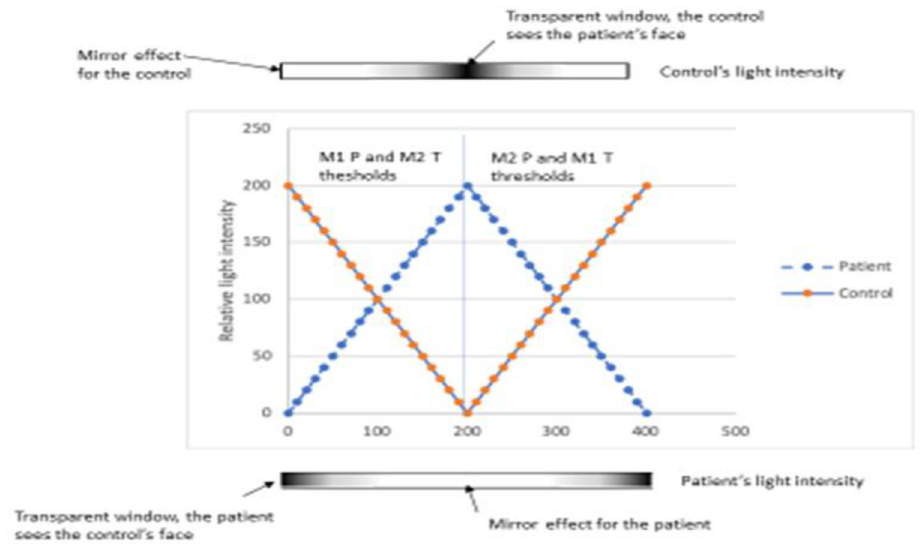
Fig 3. Synthesis of the experimental procedure during one “passage back and forth”. During the task, the image the ASD patient sees undergoes a morphing from other to self and then from self to the other. Simultaneously, the image the TDC sees undergoes a morphing from self to other and then from other to self. The threshold M1 corresponds to the light intensity at which the perceptual shift from other to self occurs. The M2 threshold corresponds to the light intensity at which the perceptual shift from self to other occurs. The procedure is then repeated a second time. Thus, for each subject, 2 M1 and 2 M2 thresholds are obtained.